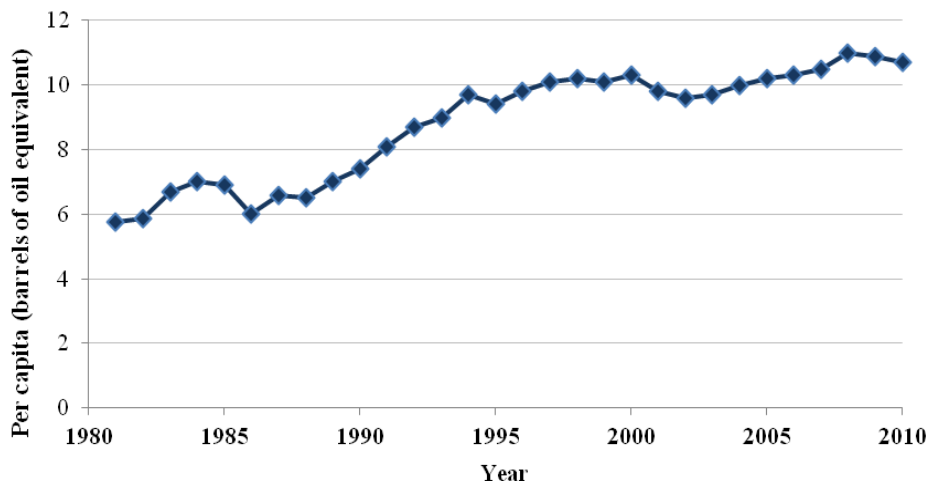
Figure 2. Per capita energy